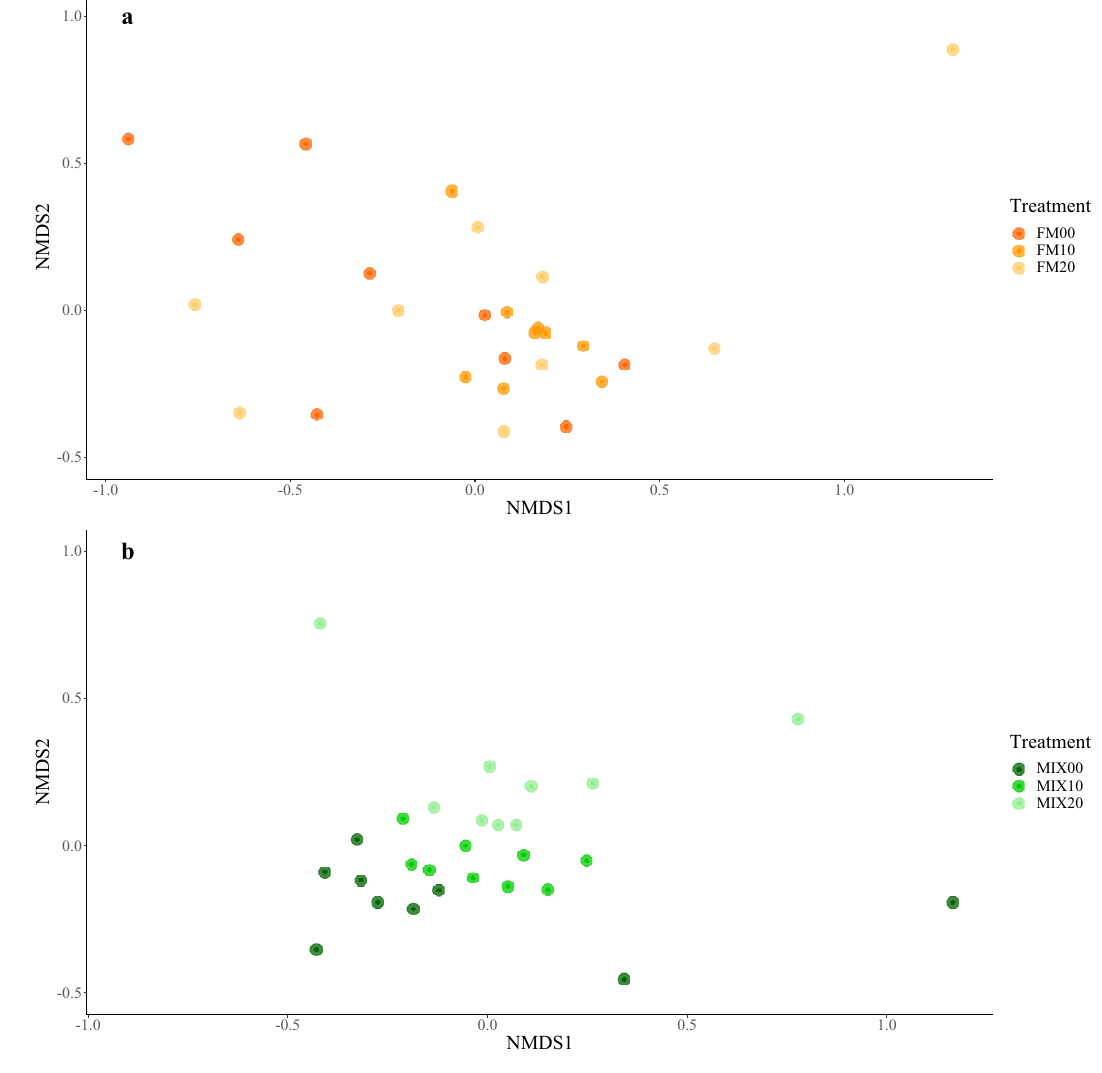
Figure 4. Non-metric multidimension scaling (NMDS) of fish from ( a) FM feed treatments, ( b) MIX feed treatments. Each point represents a single fish and colour indicates the feed treatment inclusion